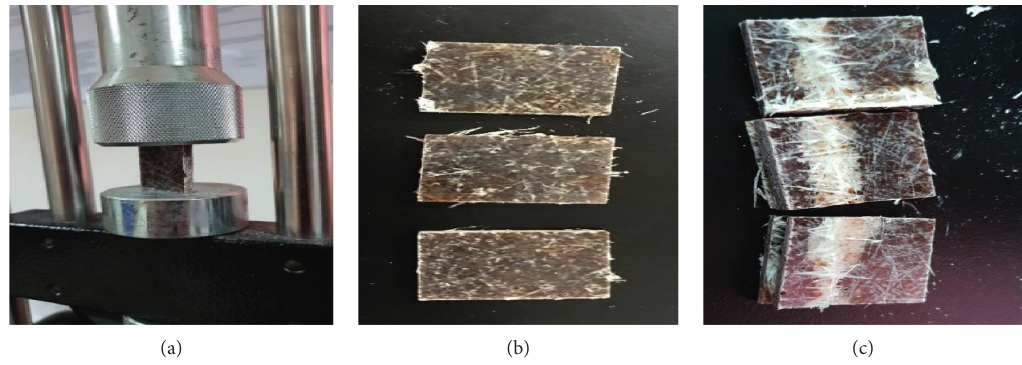
Figure 9: (a–c) Compression specimens before and after deformation.